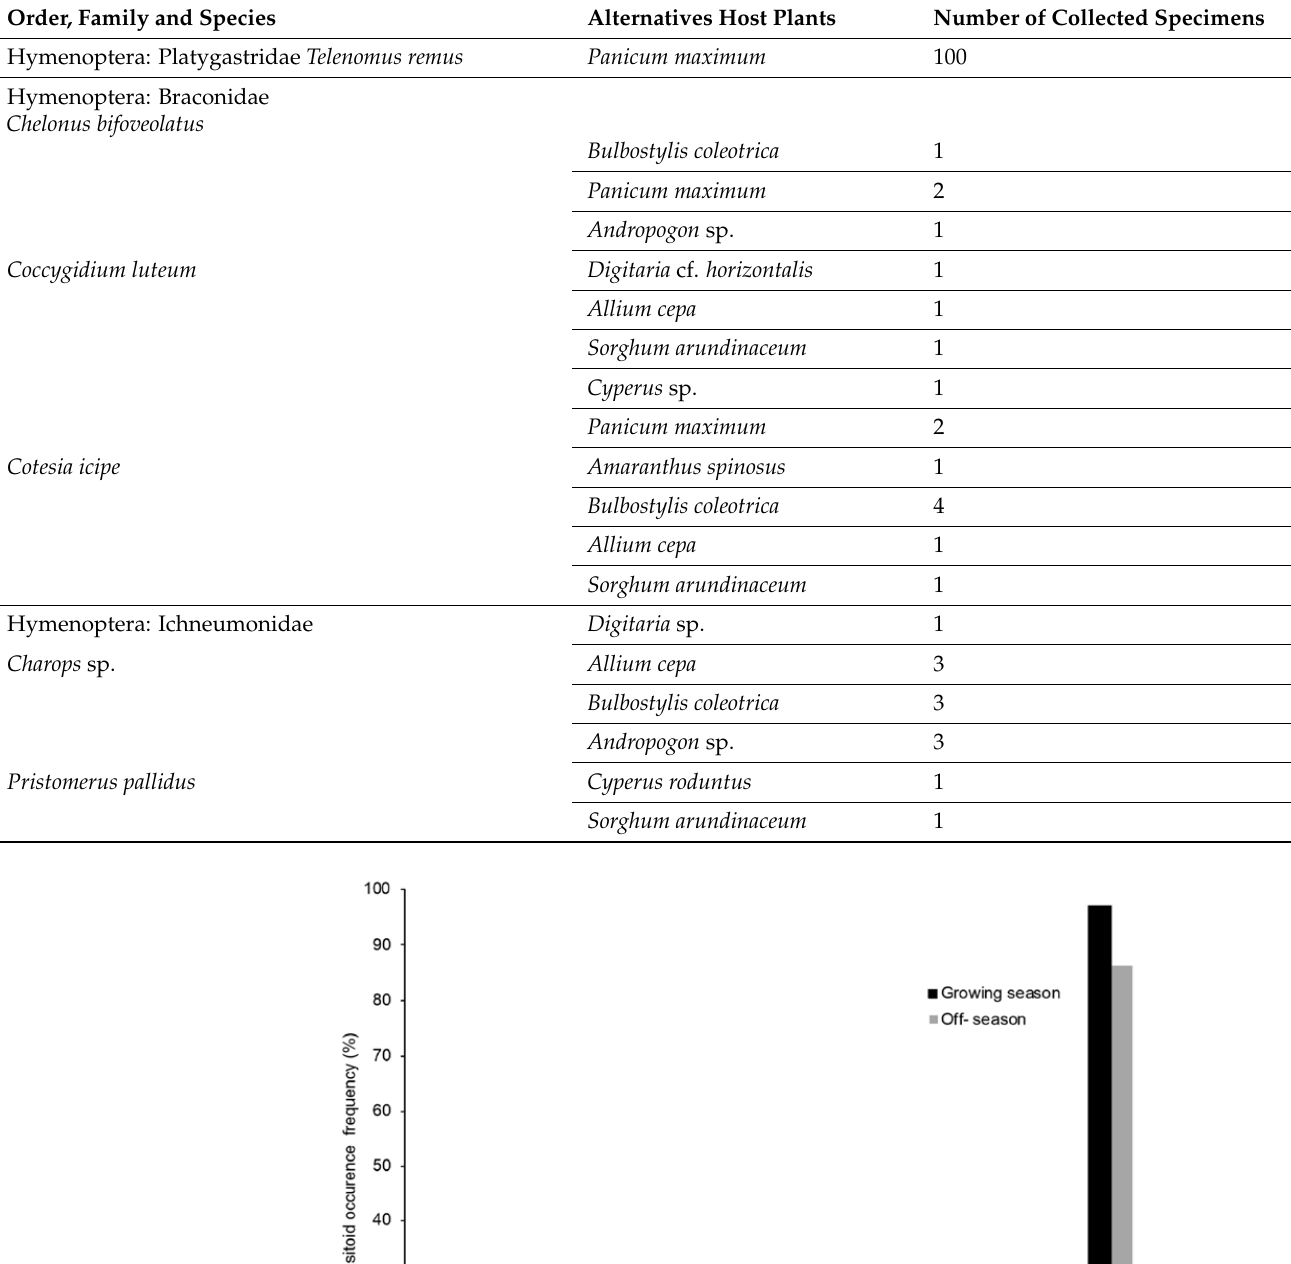
Table 3. FAW parasitoids recorded on the pest eggs and larvae collected on alternative host plants.